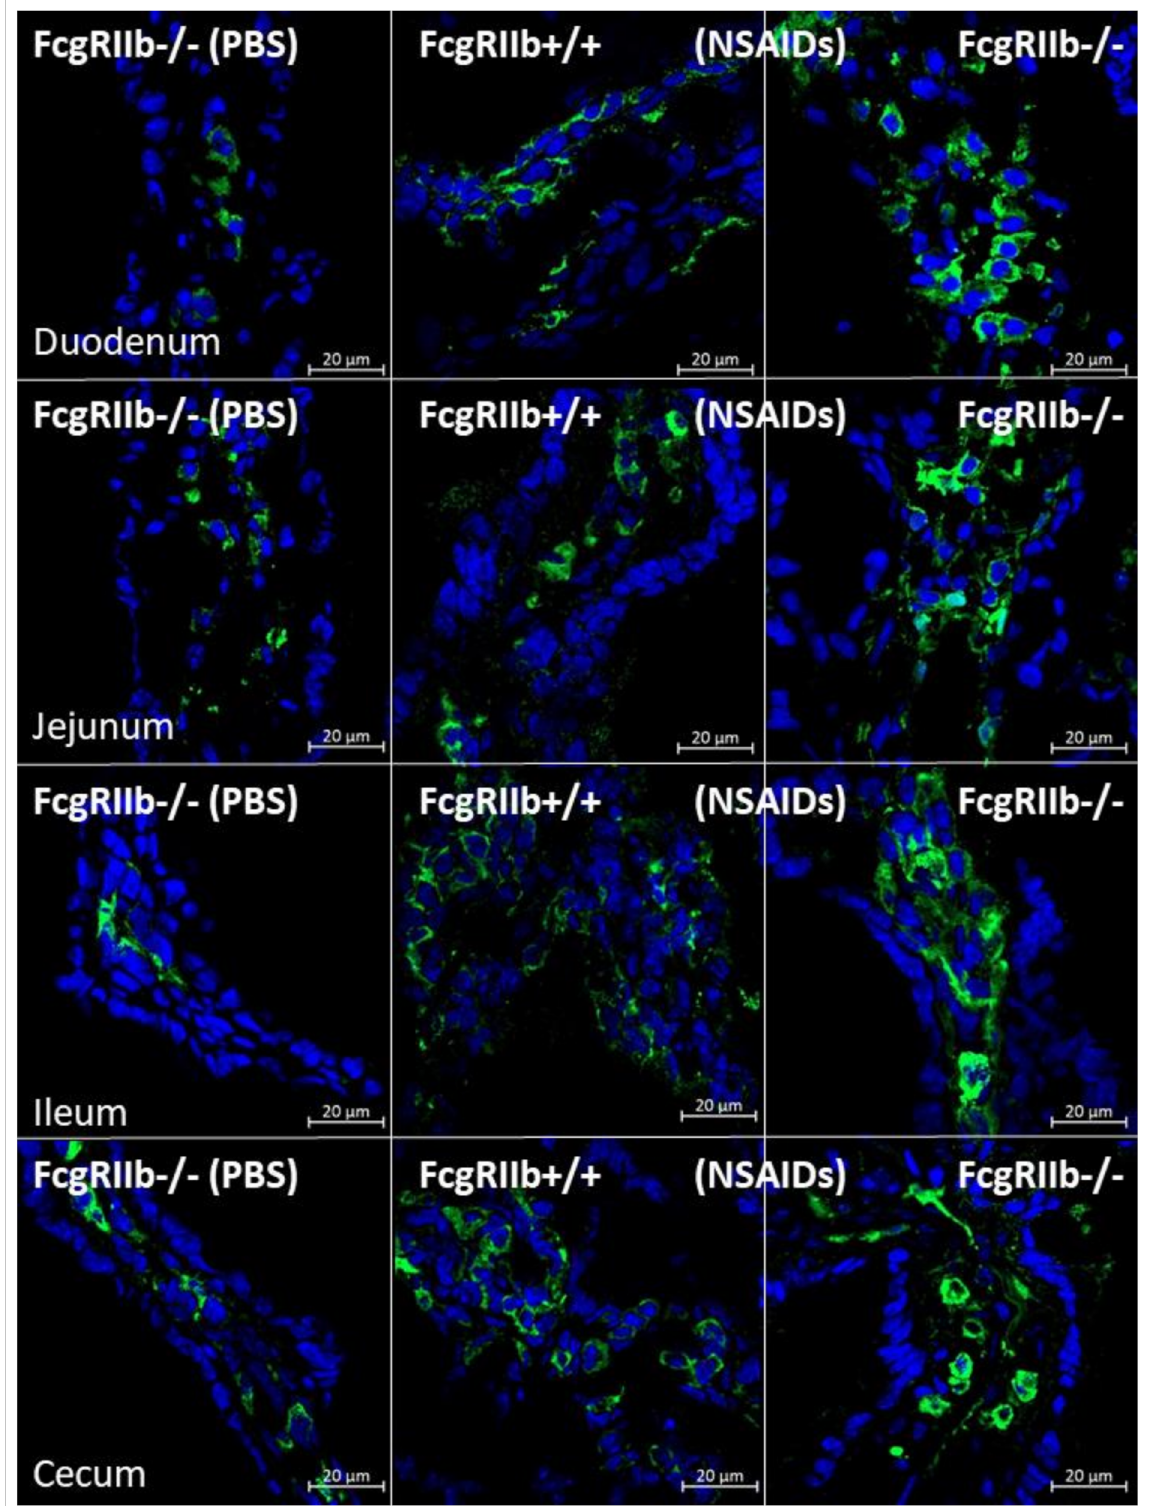
Figure 5. Representative figures of immune deposition in the intestines of FcgRIIb-/- lupus mice and wild-type (FcgRIIb+/+) mice after the administration of indomethacin (NSAIDs) or phosphate buffer solution (PBS) control (original magnification 200 × ) are demonstrated. of PBS-administered wild-type control mice (FcgRIIb+/+ PBS) were not demonstrated due to the non-detectability of immune deposition. Green and blue colors demonstrate mouse IgG and intestinal nuclei,